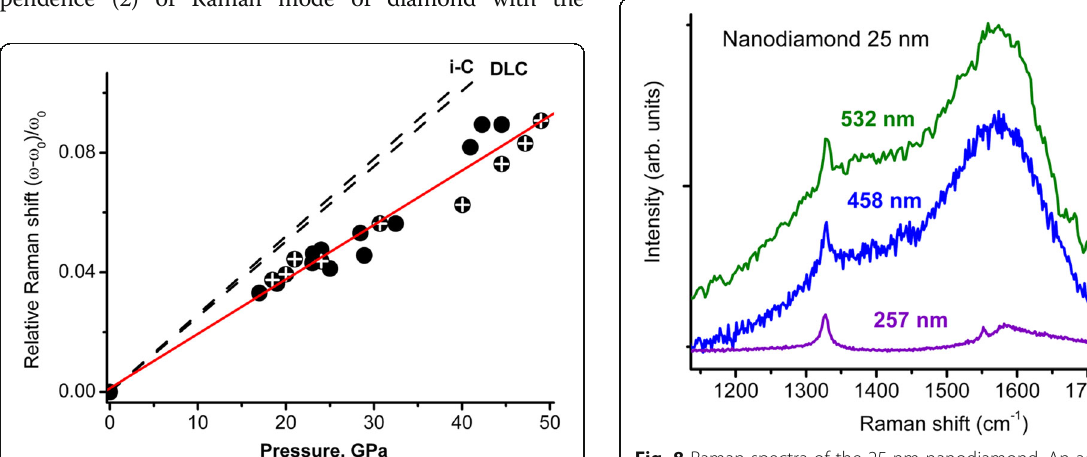
Fig. 8 Raman spectra of the 25-nm nanodiamond. An additional band around 1580 cm − 1 shows a typical behavior for a G band of the sp 2 -bonded carbon: the intensity decreases by a factor of 50 – 100 upon changing the excitation wavelength from 532/458 nm to 257 nm. A luminescence background is subtracted from the spectra with the excitation wavelength from 532/458